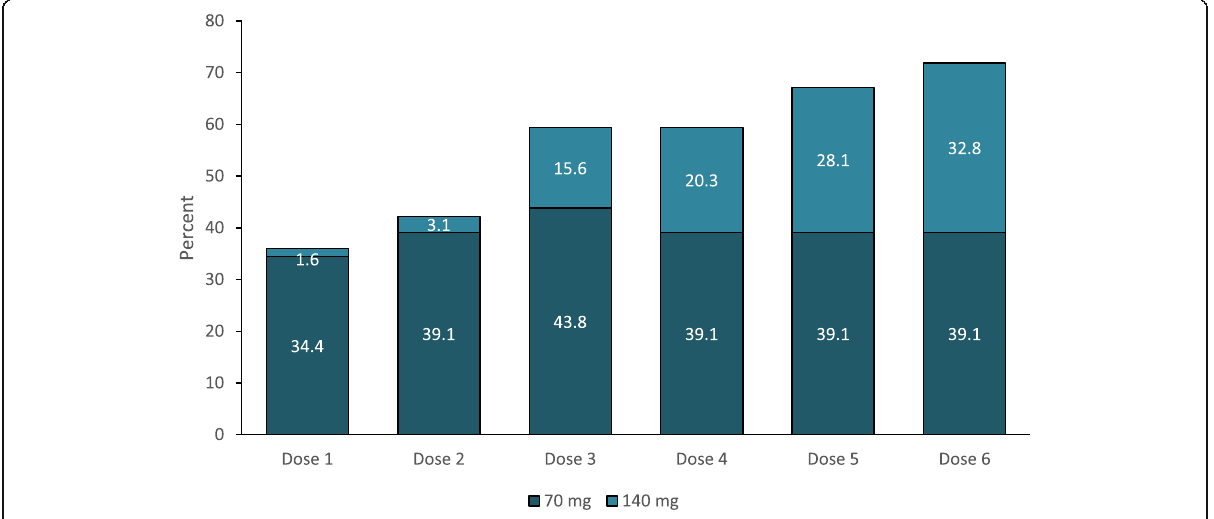
Fig. 4 Proportion of patients withdrawing medication overuse according to erenumab